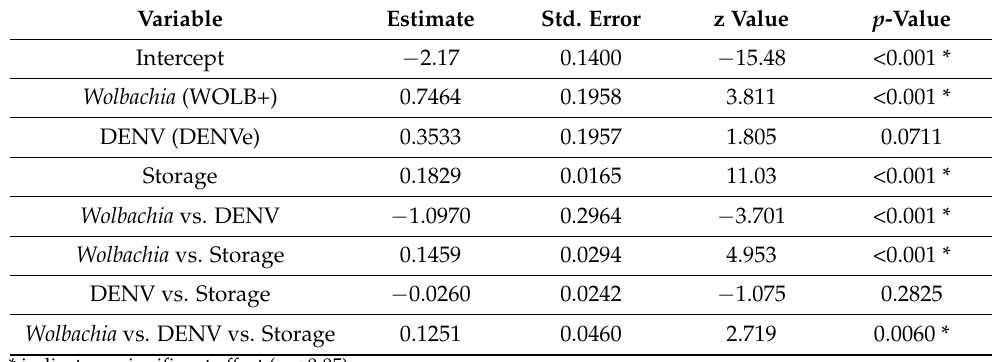
Table 3. Logistic regression for the effect of Wolbachia presence, DENV exposure and storage time on egg collapsing.